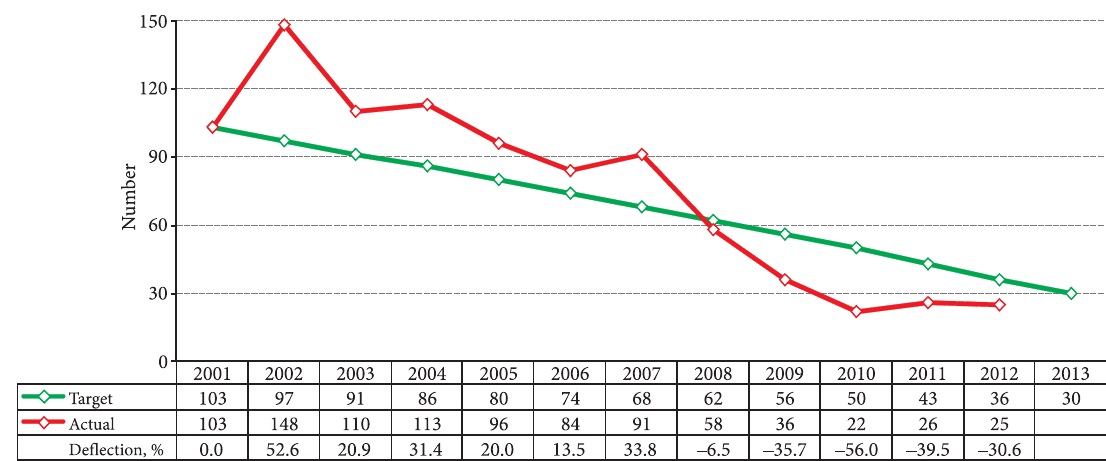
Fig. 13. Number of the killed in accidents caused by driving under the influence of alcohol and the target for